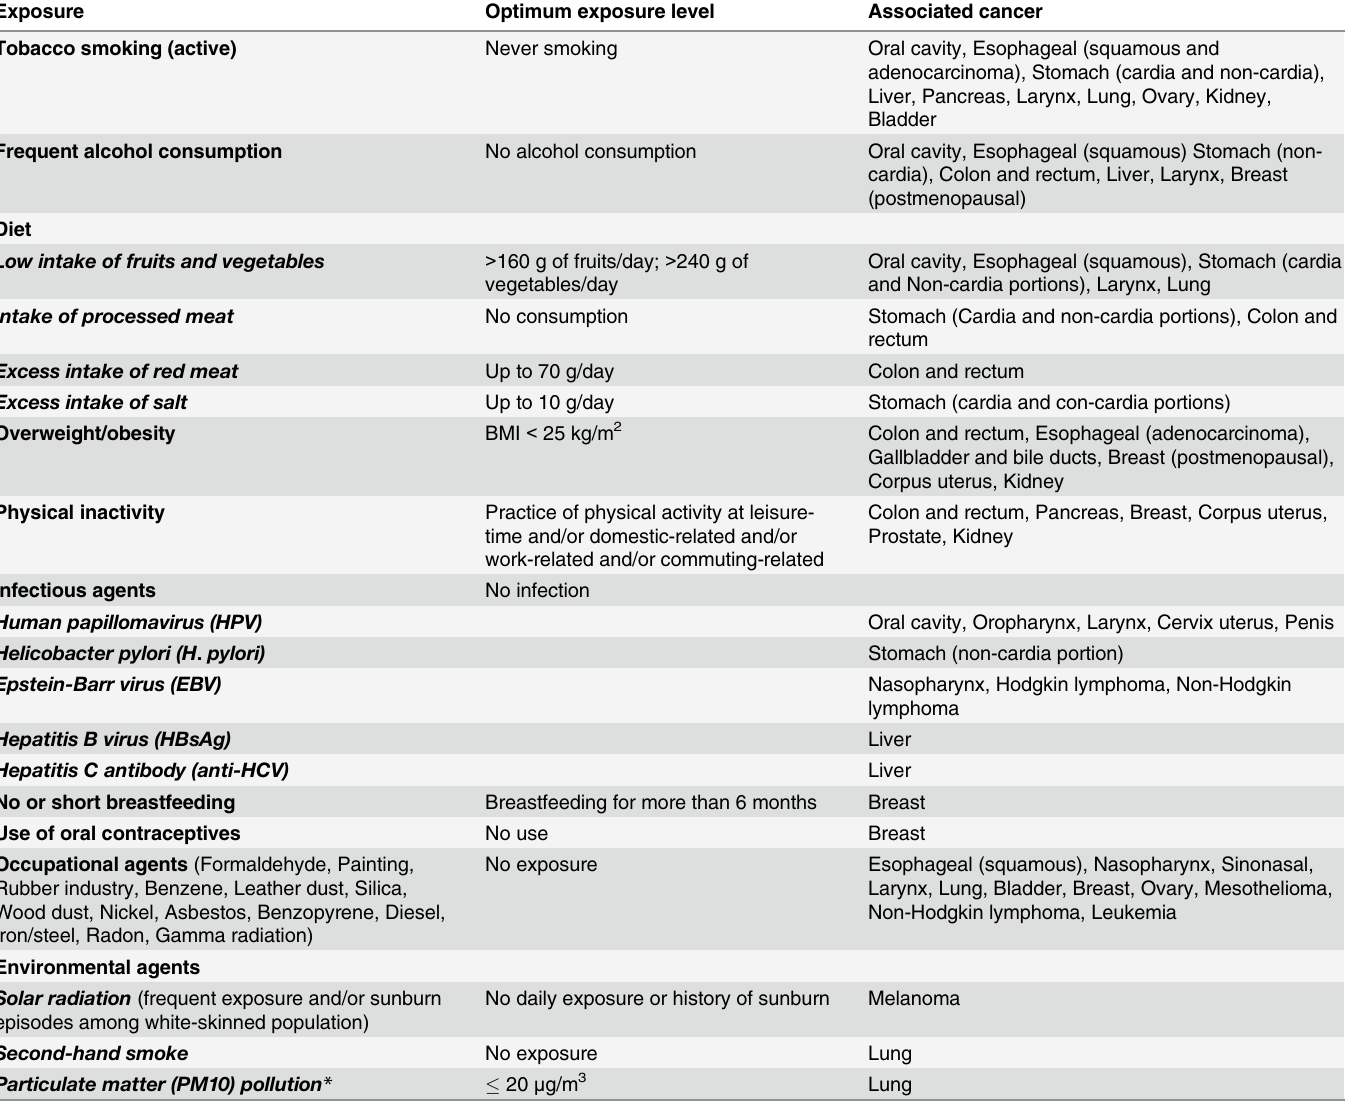
Table 1. Risk factors, theoretical optimum exposure level, and associated